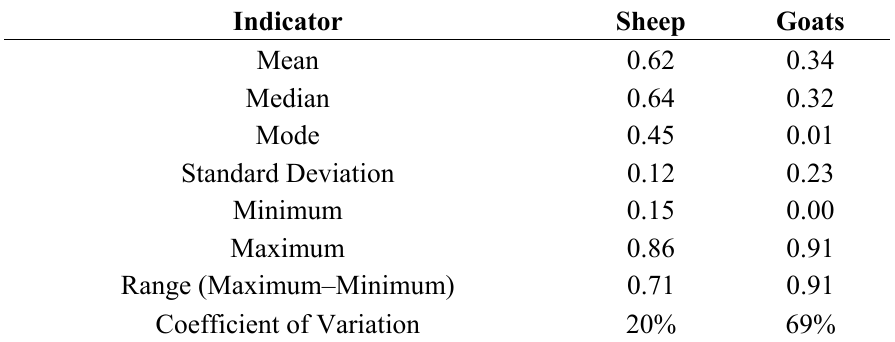
Table 6. Descriptive statistics of technical efficiencies parameters for sheep and